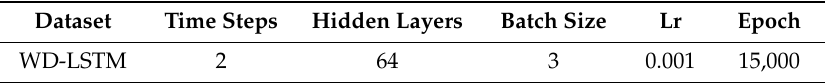
Table 1. Parameters for the LSTM